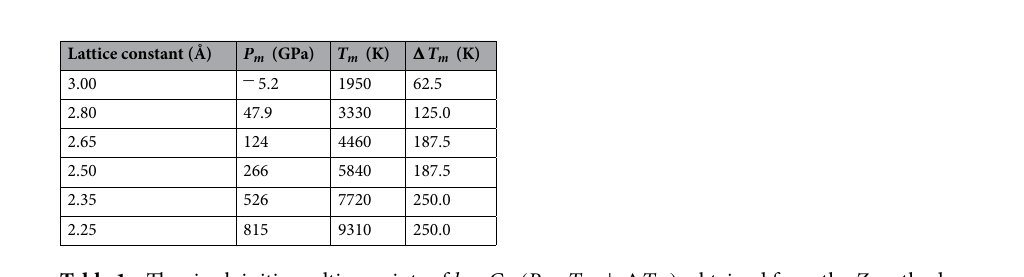
Table 1. The six ab initio melting points of bcc -Cr, ( P m , T m implemented with